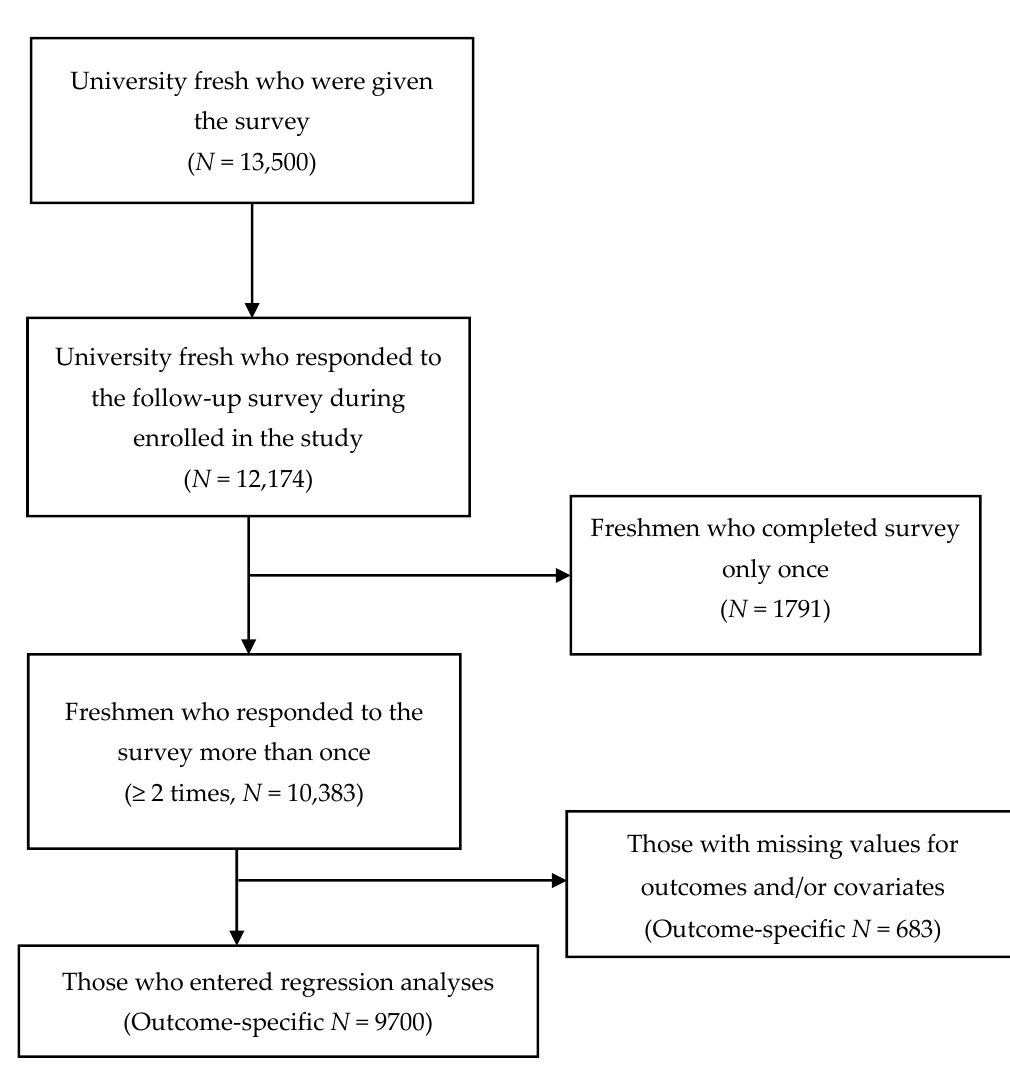
Figure 1. Study Sample